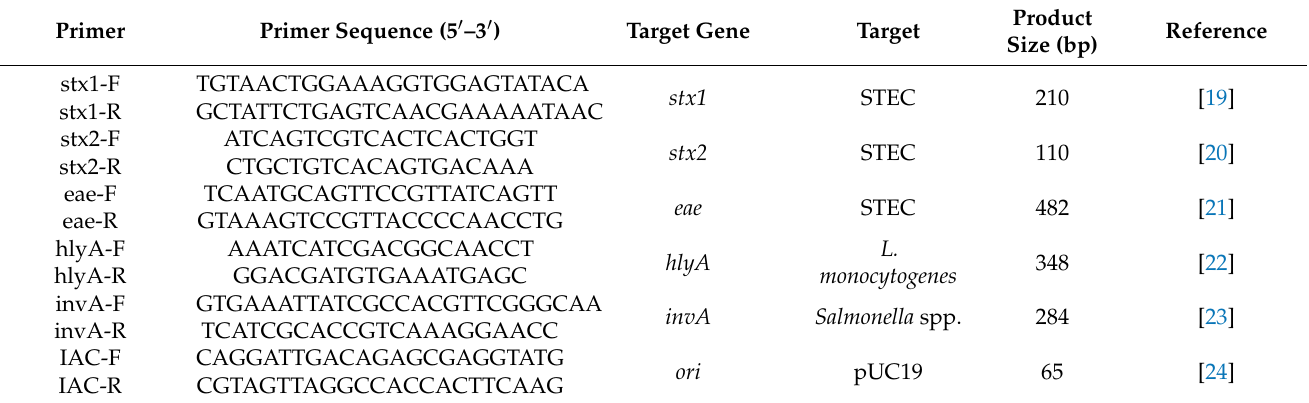
Table 3. Primer pairs and target genes used for the developed mPCR